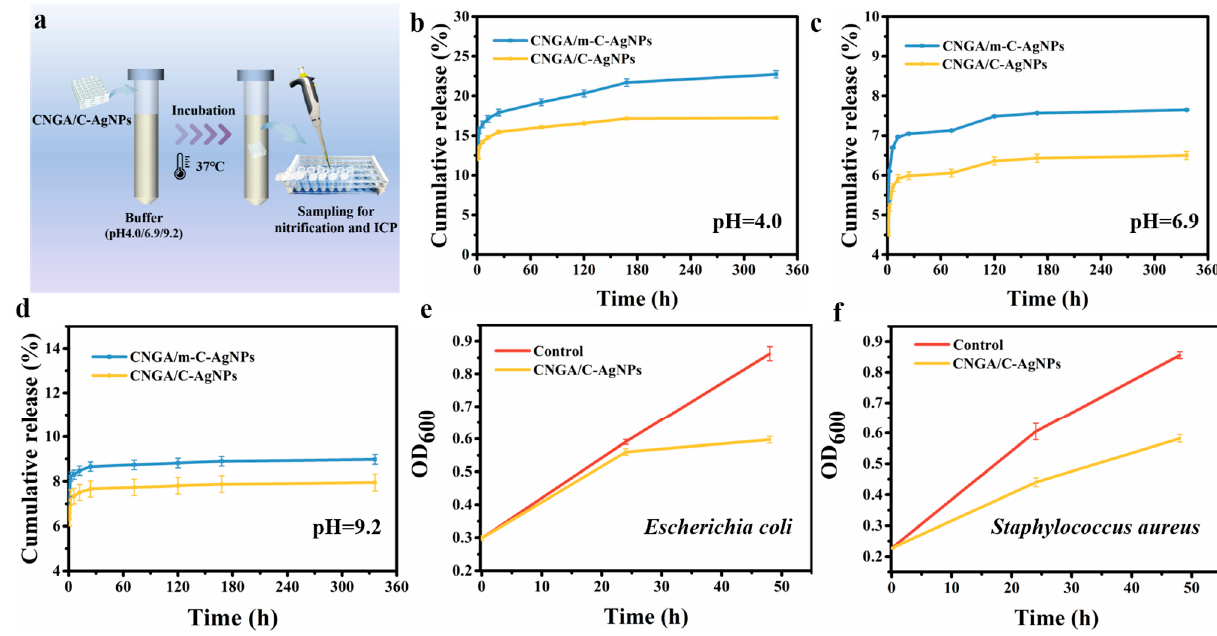
Figure 7. ( a ) Schematic diagram of Ag release experiment. Cumulative release rates of silver nanoparticles under different pH: ( b ) pH 4.0, ( c ) pH 6.9, and ( d ) pH 9.2. OD 600 curves of ( e ) E. coli and ( f ) S. aureus.